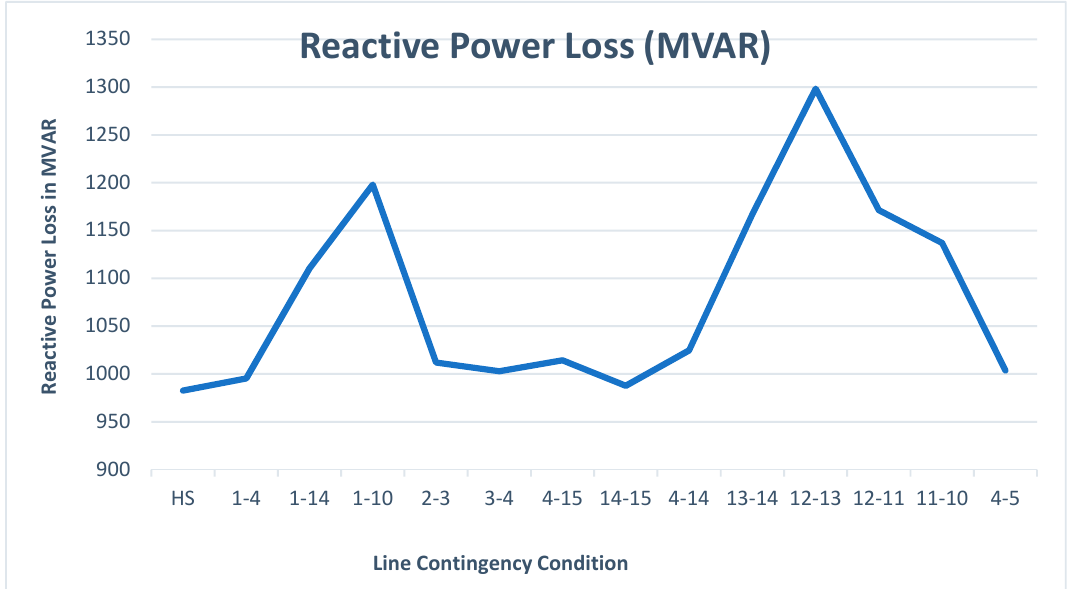
Figure 5. Active Power Loss in various line contingencies. HS = Healthy System.